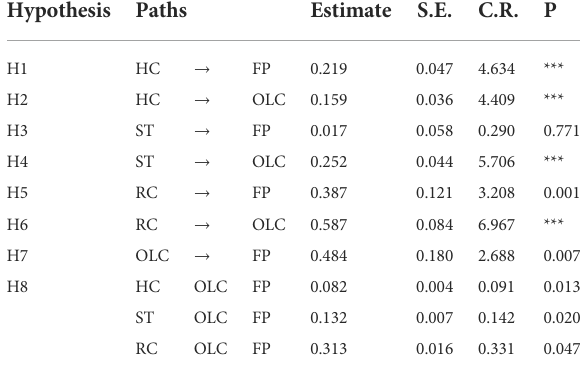
TABLE 4 Results for hypothesis